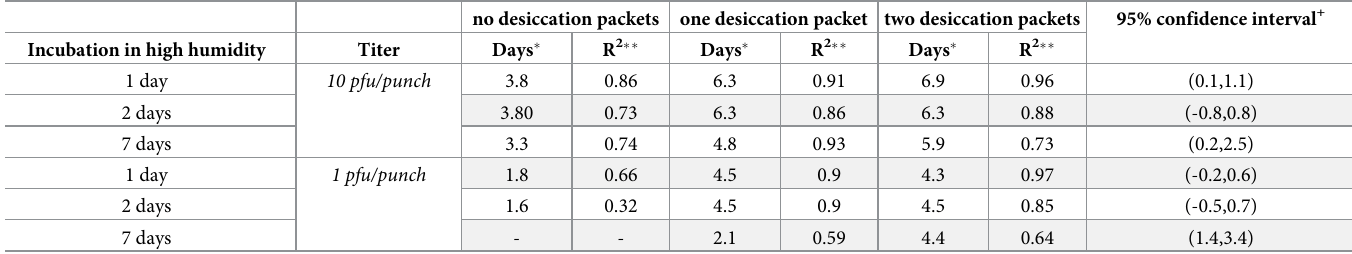
Table 3. FTA card desiccation prior to inoculation improves YFV RNA